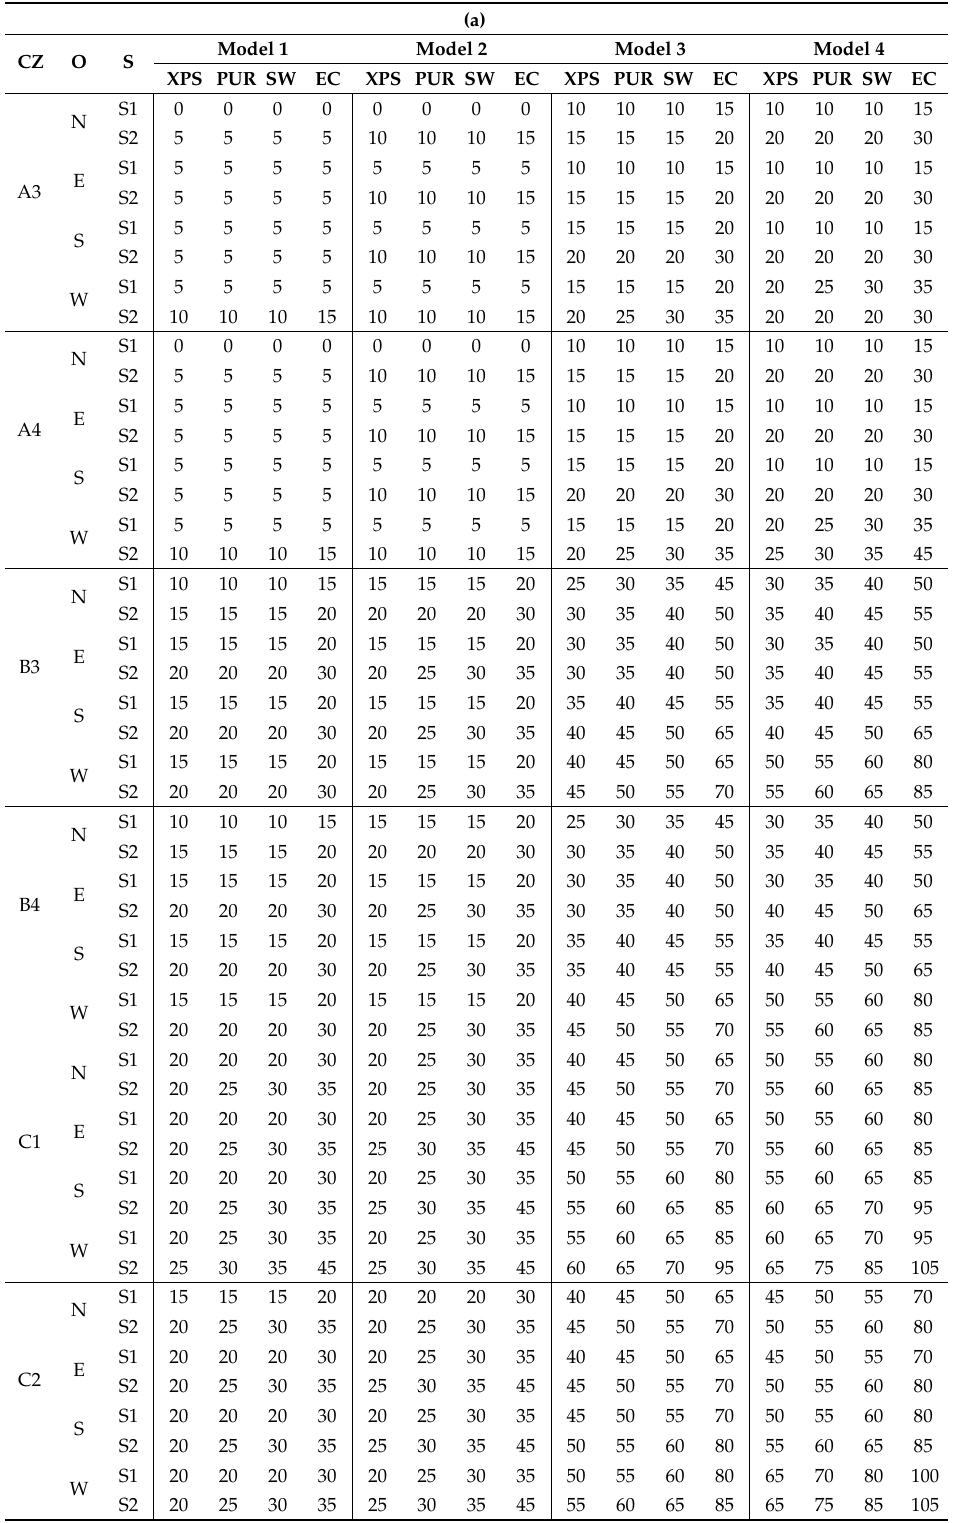
Table A1. Insulation thicknesses (in mm), for Hypothesis 1: Legal Minimum